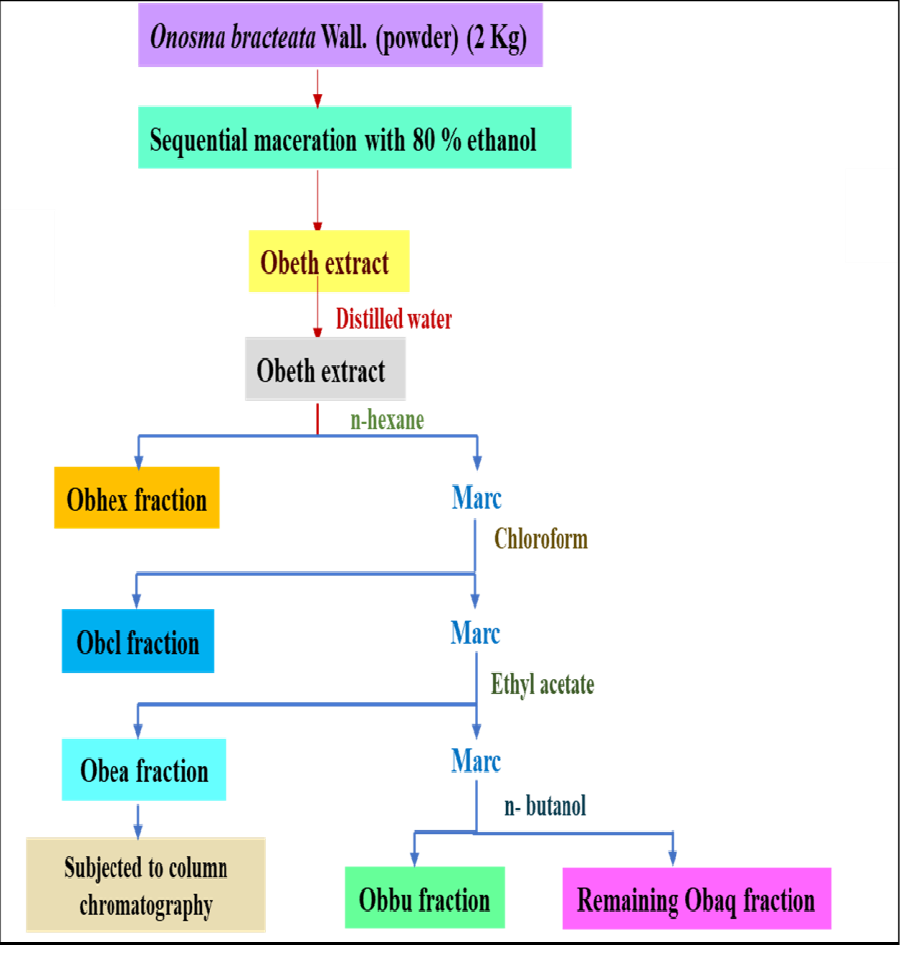
Figure 17. Schematic representation of extraction from O. bracteata using the maceration